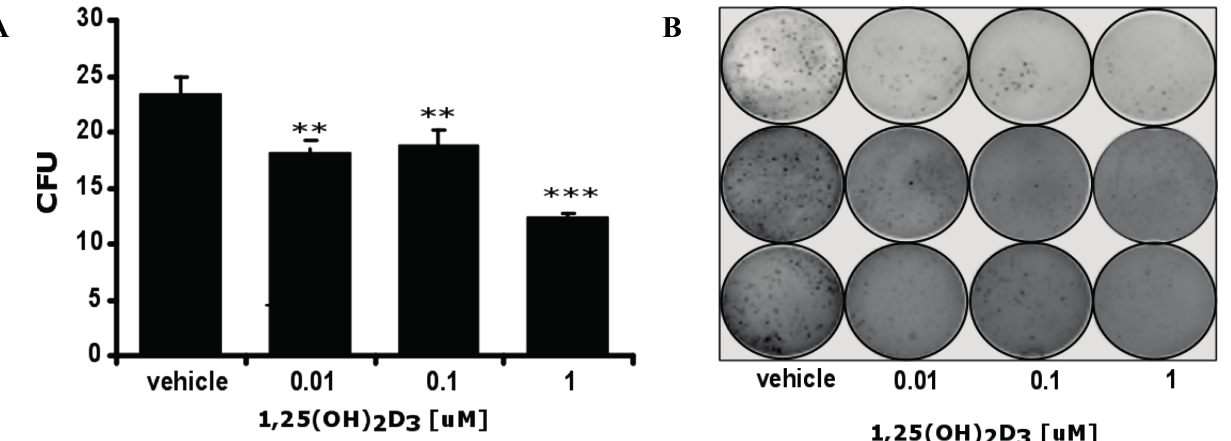
Figure 4. 1,25(OH) 2 D 3 inhibits Ab hamster melanoma colony formation in soft agar. Ab cells were grown in soft agar in the presence or absence of 1,25(OH) 2 D 3 . After three weeks, colonies were counted. Statistical significance was estimated using the t-test and data are presented as ** p < 0.01, *** p < 0.001, ±SD ( A ); Representative plate ( n = 3) showing inhibition of Ab melanoma colony formation ( B